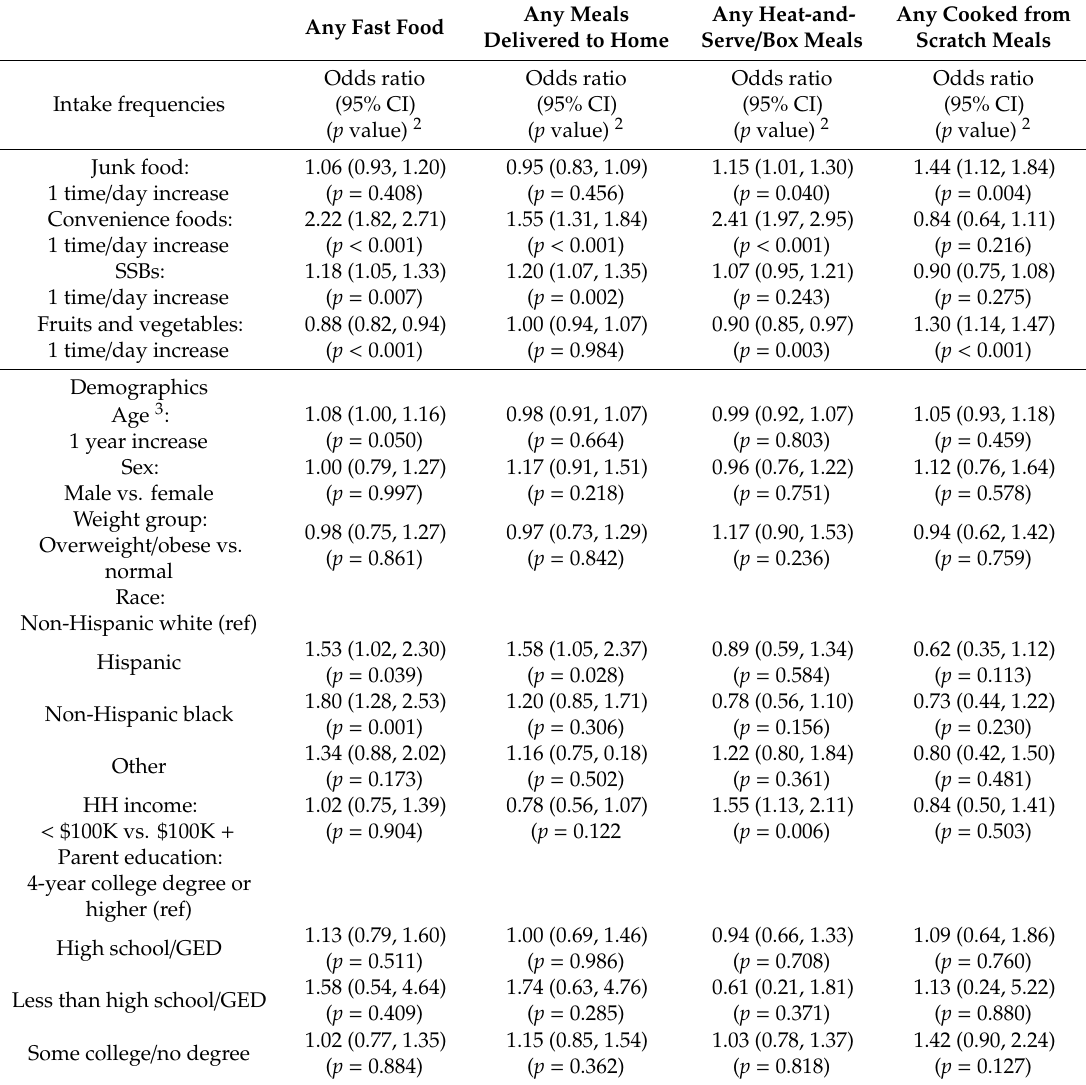
Table 2. Odds ratios 1 of evening meal types in the past week and daily intake frequencies of adolescent foods of interest and